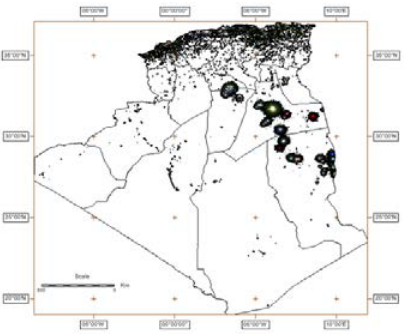
Figure 1. Temporal-spatial changes in DMSP/OLS lit areas of Algerian provinces between 1993 to 2012.